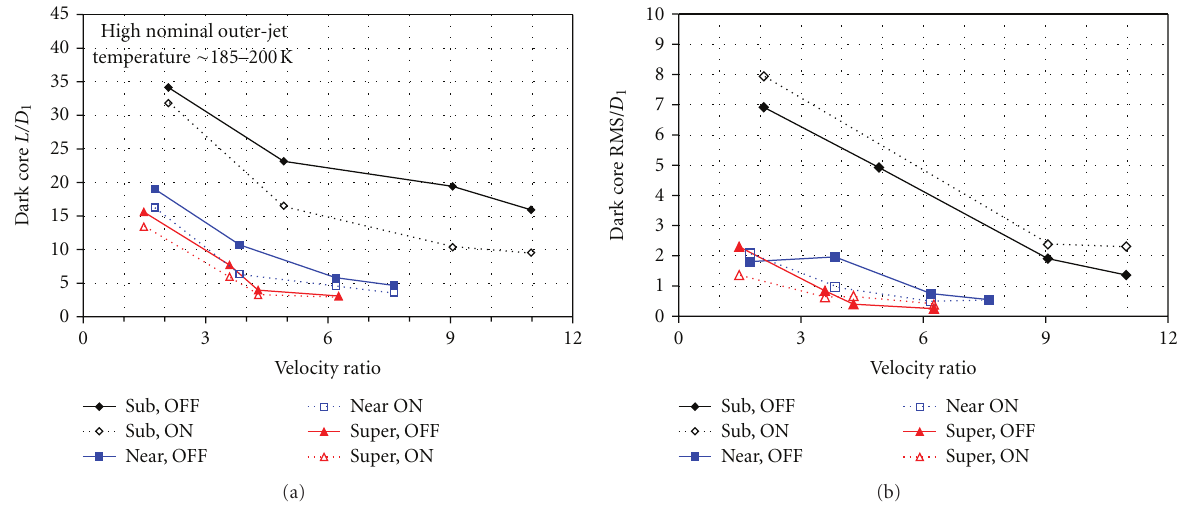
Figure 23: Plot of the averaged dark-core length (a) and the root mean square (RMS) of the length variations (b) normalized by the inner diameter of a LN 2 /GN 2 coaxial jets injector. The solid symbols and lines represent the data when the acoustic driver is o ff , and the hollow symbols and dotted lines show the data when the acoustic driver was operated at ∼ 3 kHz. The diamond, square, and up-triangle symbols are sub-, near-, and supercritical chamber pressures, respectively. All cases are for the high nominal outer-jet temperature of ∼ 190 K. In the inset, the words sub, near, and super refer to subcritical, near critical, and supercritical chamber pressures, respectively, and the words OFF and ON refer to the acoustic driver being o ff and on at ∼ 3kHz, respectively. Davis and Chehroudi [42, 43].